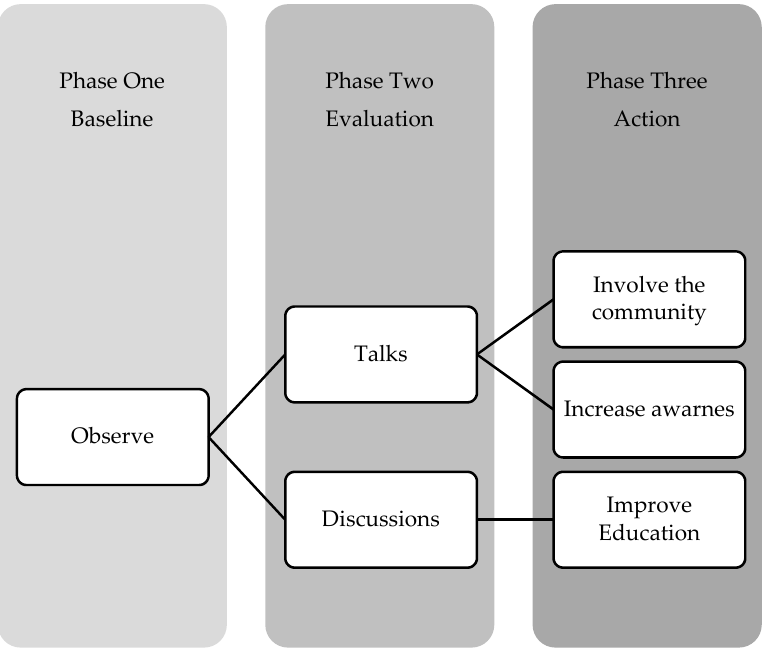
Figure 2. The first three initial phases of the AGOGHÈ Project. Firstly, the questionnaire allowed the collection of information about the community and the current situation and needs in the territory. The data reported in the present manuscript will then open up discussions and talks about the local needs, following consultation with the locals, governments, stakeholders and scientific communities. The third phase will see the beginning of the project, with activities and actions built to involve the community, increase awareness and foster education.